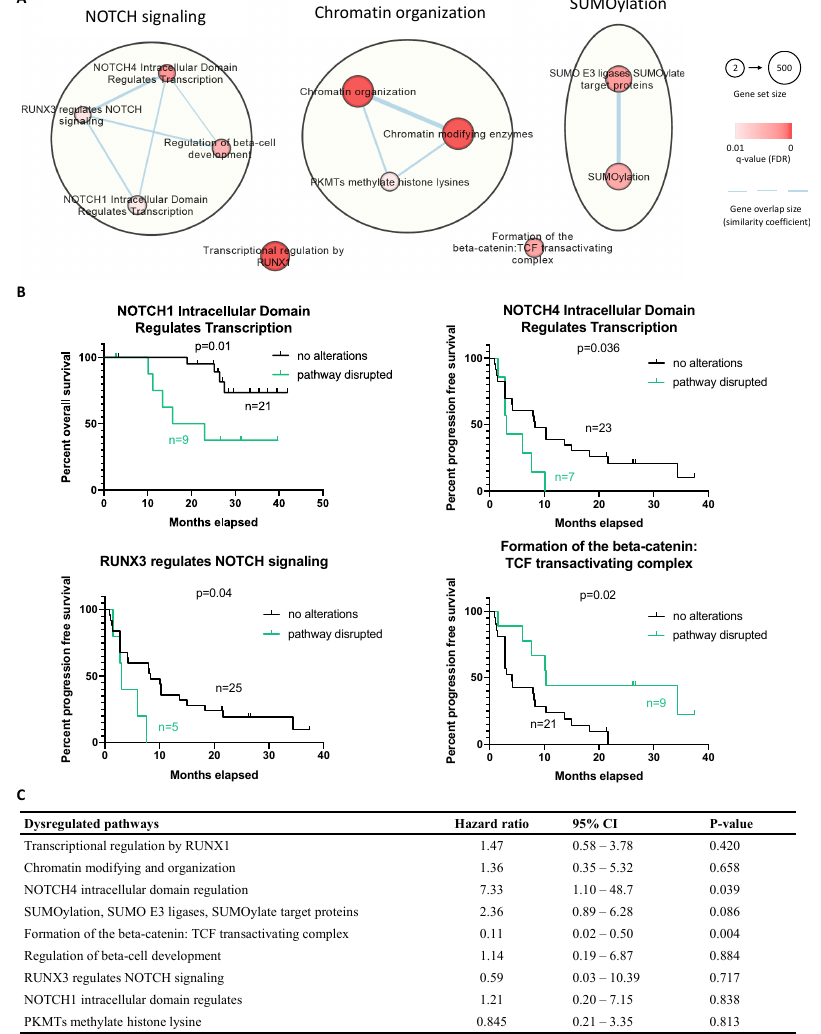
Figure 5. Integrative pathway enrichment analysis using the mutated gene list in the CGC set and the association between altered pathways and patients’ survival. ( A ) Dysregulated pathways were mainly related to NOTCH signaling, chromatin organization, and SUMOylation damage. Red-coded nodes represented as the significantly dysregulated pathways, and the significance was marked by color intensity. The size of the node represents gene set size (number of genes documented in each pathway). The edges (gene overlap size), represented as the associations between pathways and the thickness, were used to present the associated level. ( B ) Progression-free survival for cases with and without dysregulated pathways. ( C ) Univariate Cox regression analysis of dysregulated pathways upon progression-free survival; p -value < 0.05 is considered significant.